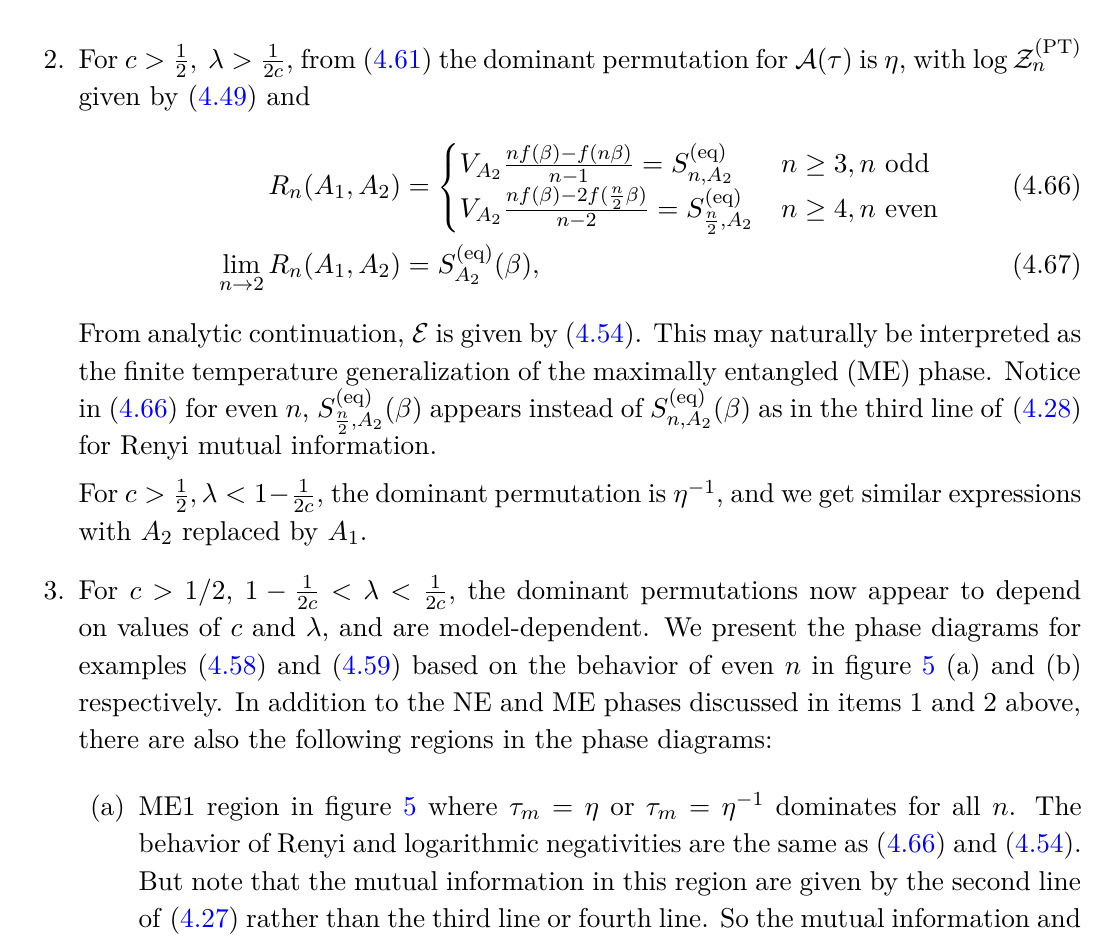
Figure 5 . Phase diagrams for the canonical ensemble in a homogeneous system. (a) shows the case with f ( β ) as in (4.58), and (b) shows the case with f ( β ) in (4.59). Note that in (a), in addition to the ab , bc and ac regions, there is also a small abc region near the intersections of these regions which is not shown explicitly in the figure. The dashed lines show the prediction for the phase transition in the logarithmic negativity from the naive analytic continuation prescription, where we set E = E or E = E in ES NE ES ME